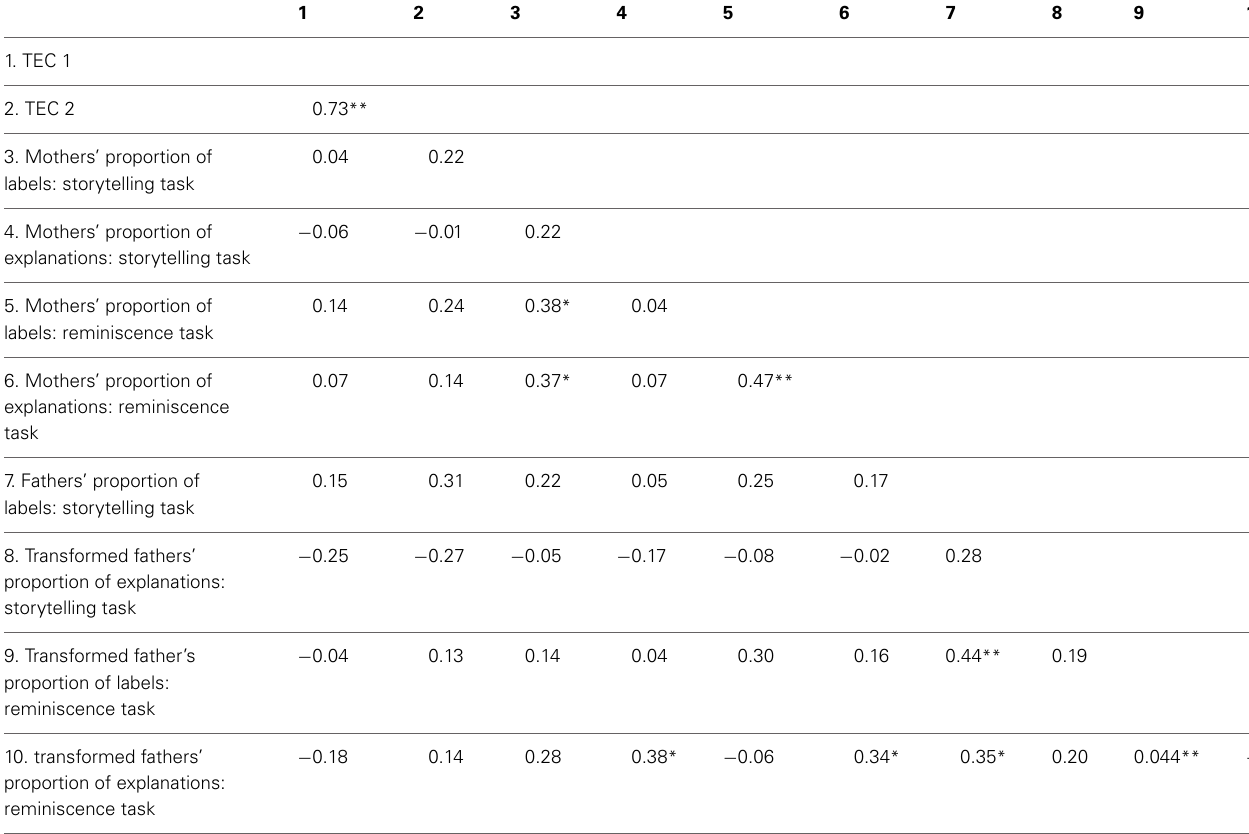
Table 2 | Relations between parental emotion talk, and children’s emotion understanding at age